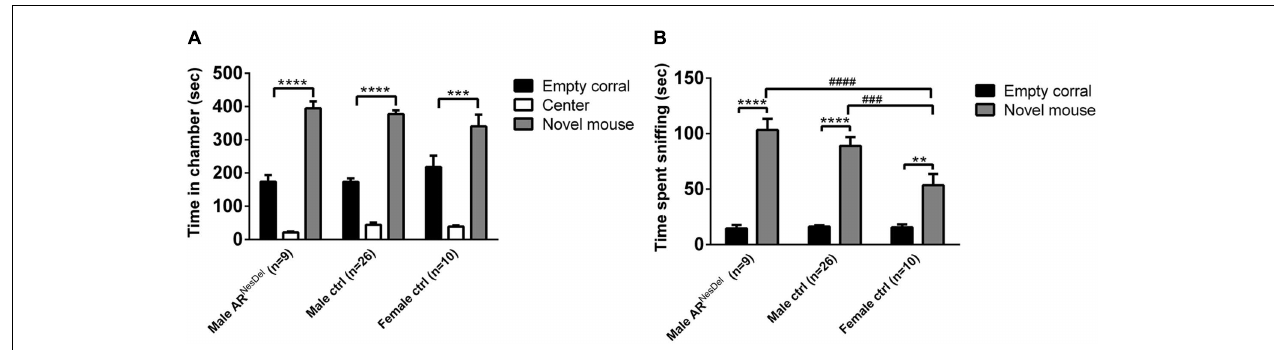
FIGURE 1 | Sociability measured with the three-chambered apparatus test in AR NesDel males, male controls (wildtype, AR flox , NesCre + / − ), and female controls (ARflox + / − ). (A) Amount of time spent in the each chamber during the 10 min test of sociability. (B) Amount of time spent sniffing the empty corral or the novel mouse. Bars represent mean ± SEM, ∗∗ p < 0.01, ∗∗∗ p < 0.001, ∗∗∗∗ p < 0.0001 (within-group comparison) and ### p < 0.001, #### p < 0.0001 (between-group comparison).